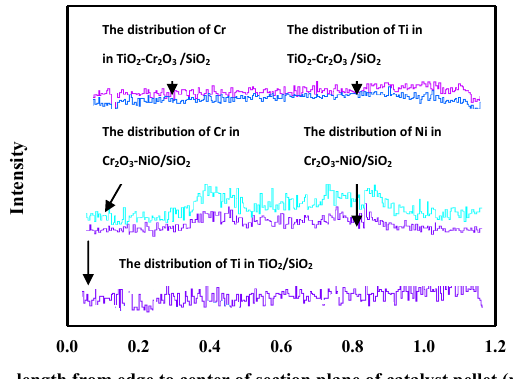
Figure 7. The distributions of Ti, Cr and Ni in the cross section of catalyst pellets: 2.9 wt% TiO 2 /SiO 2 -500, 7.1 wt% Cr 2 O 3 -6.3 wt% NiO/SiO 2 -500, and 1.4 wt% TiO 2 -6.1 wt% Cr 2 O 3 /SiO 2 -500 from edge to center.